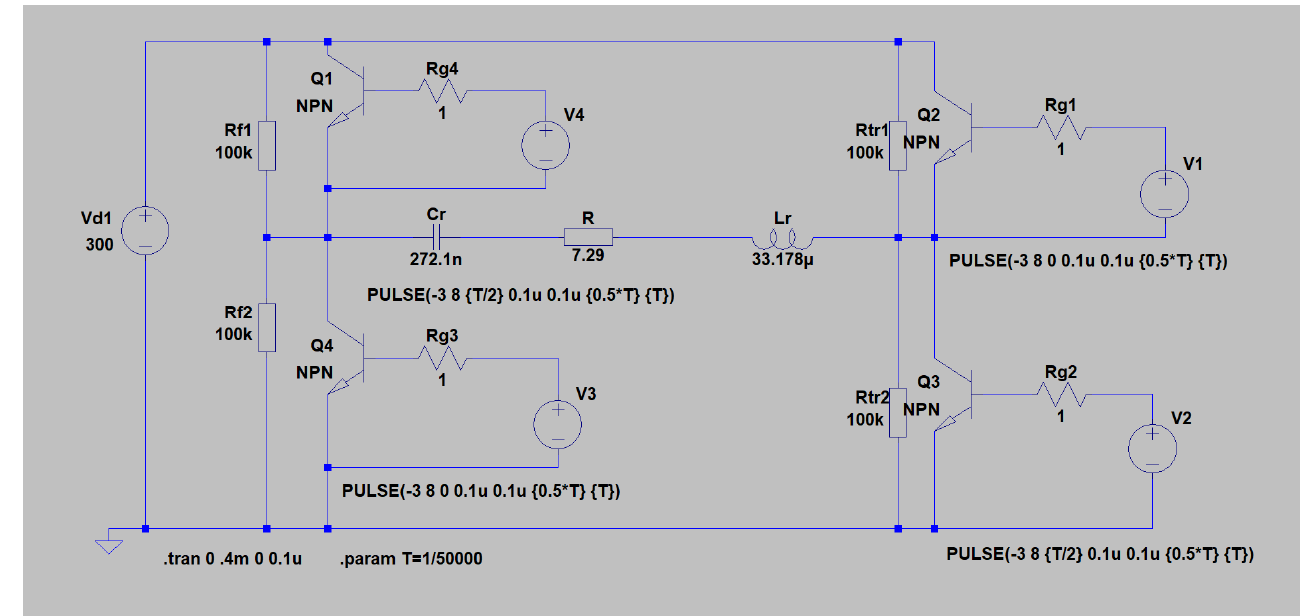
Figure A2. Simulation model of a series resonant inverter without reverse diodes.